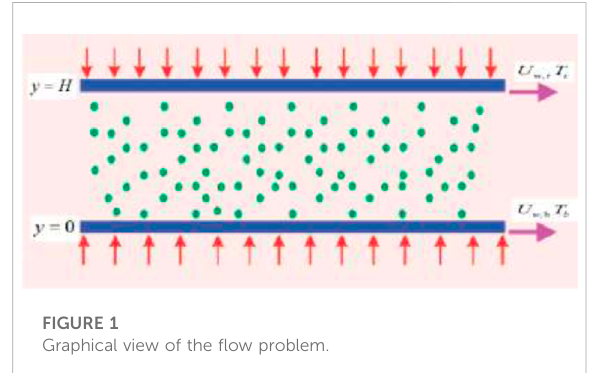
FIGURE 1 Graphical view of the fl ow